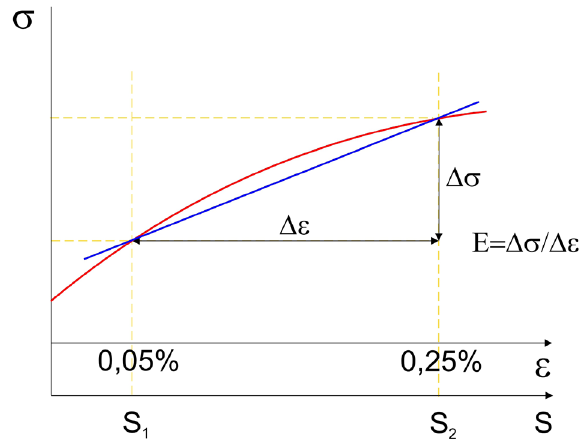
Figure 8: Ring stiffness for 200 mm diameter